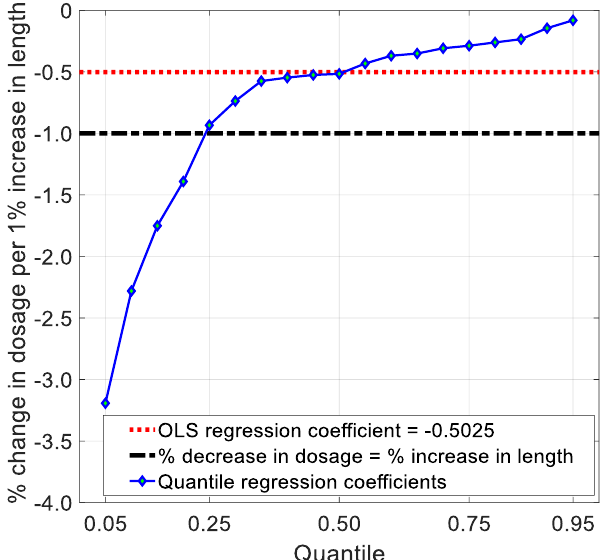
Figure 4. Quantile regression plot of relative change in dosage per 1% increase in route length.